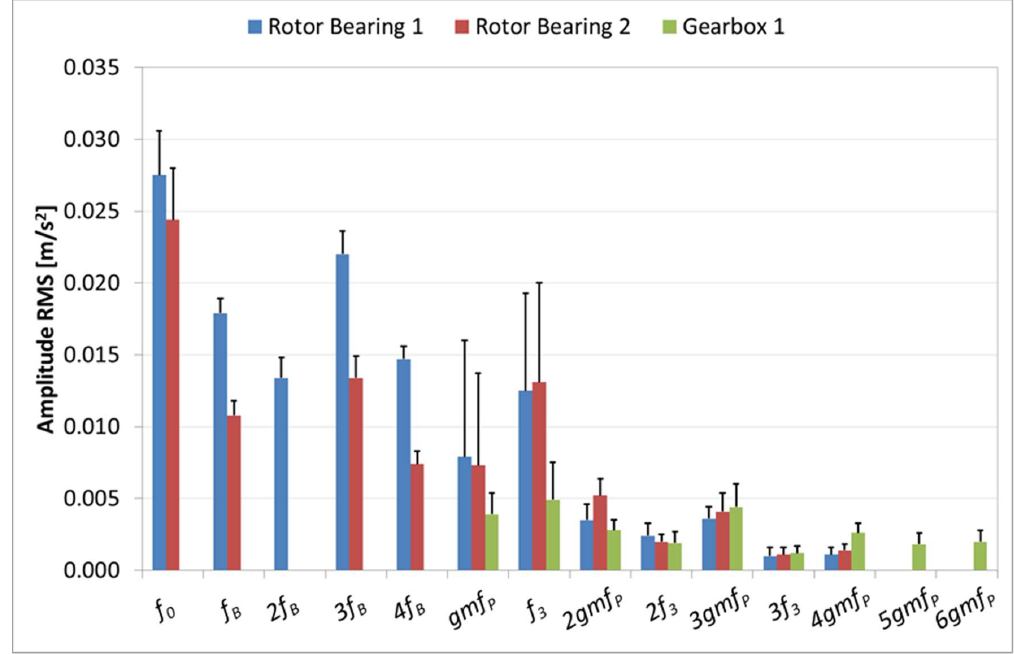
Figure 9. Mean vibration acceleration RMS and standard deviation values for the main frequencies on the low speed side of the drive train.